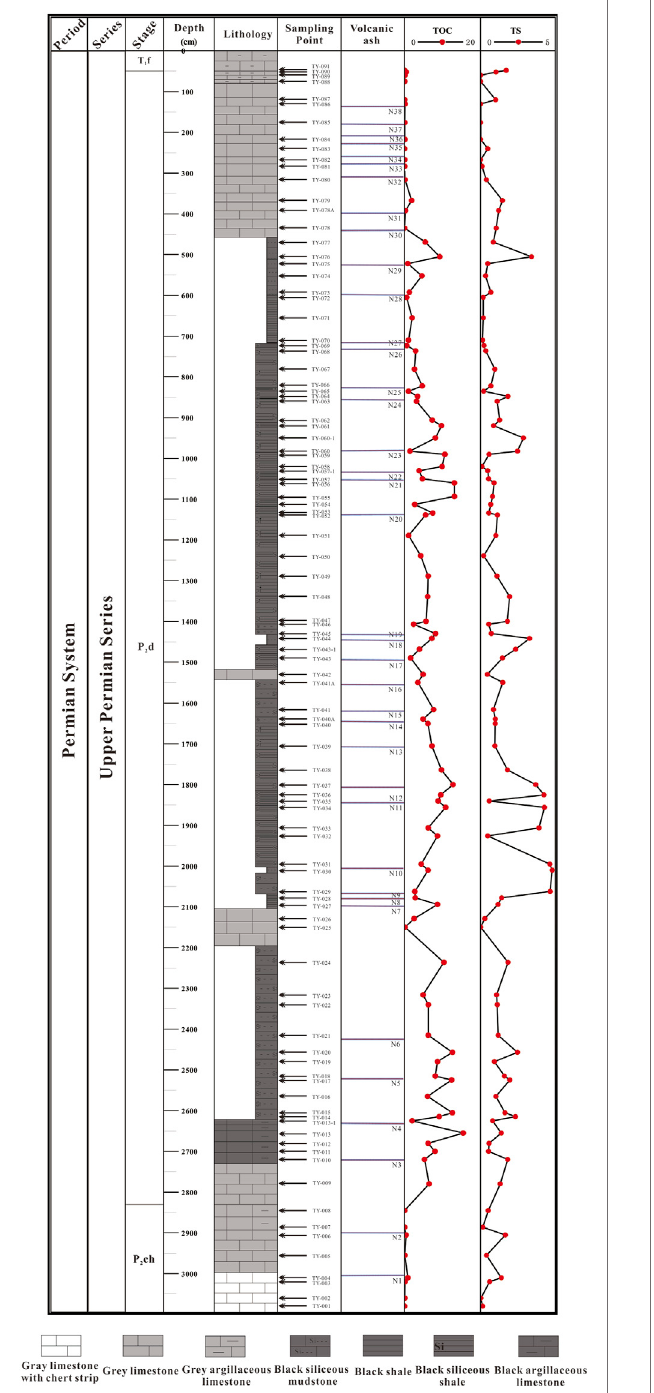
FIGURE 4 | Longfeng quarry pro fi le sampling location and sample TOC and TS data.